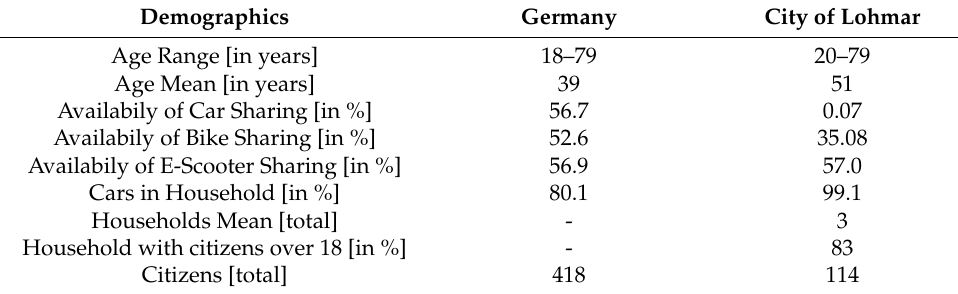
Table 1. Demographics of the use case online survey